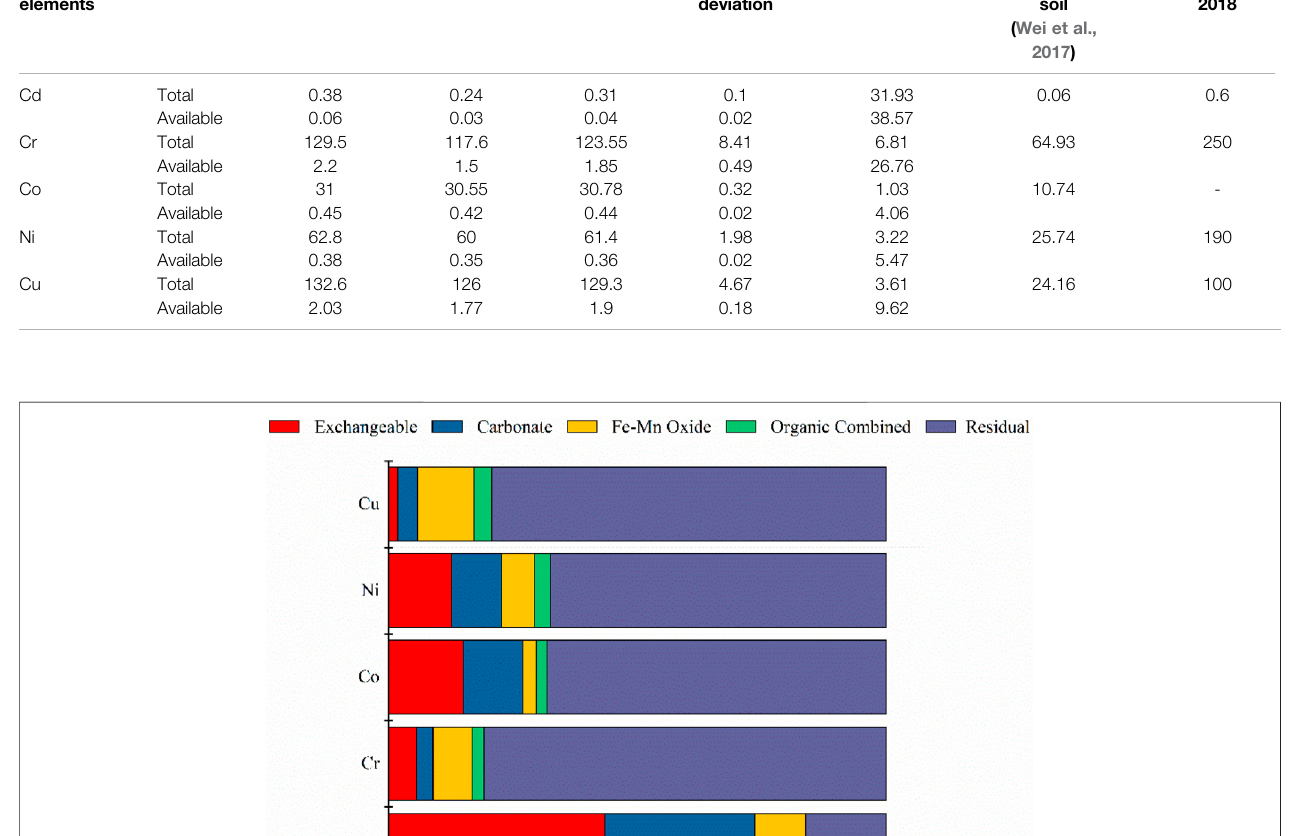
TABLE 5 | Comparison of trace heavy-metal content in fl y ash and background value of each element (mg/kg). Metallic elements